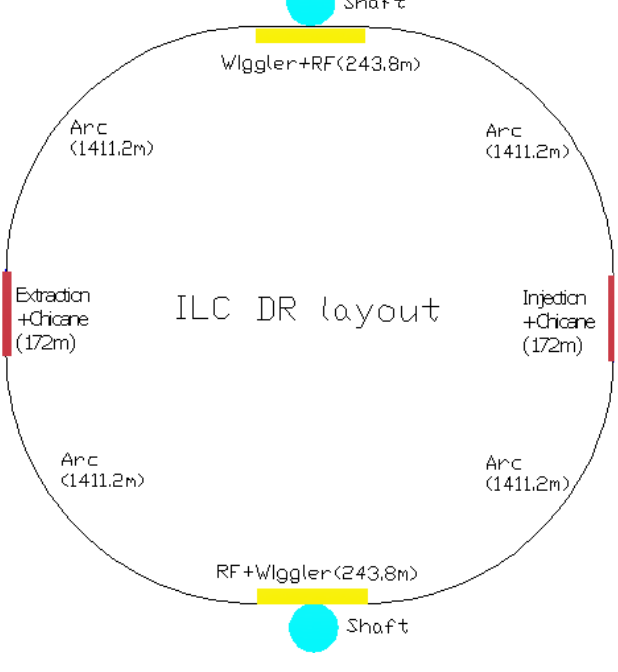
FIG. 1. (Color) FODO damping ring layout.